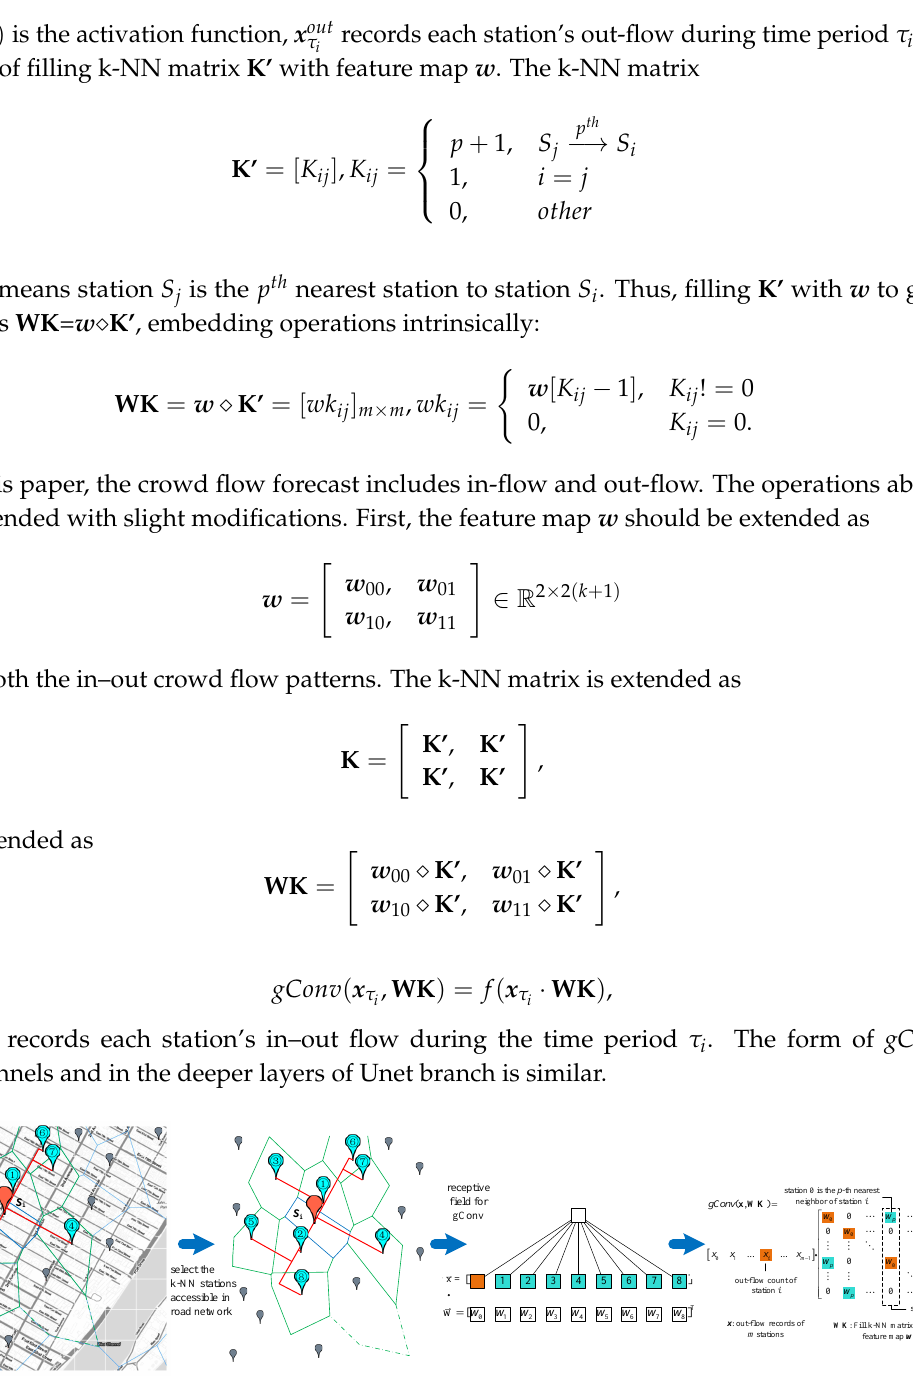
Figure 7. The details of gConv